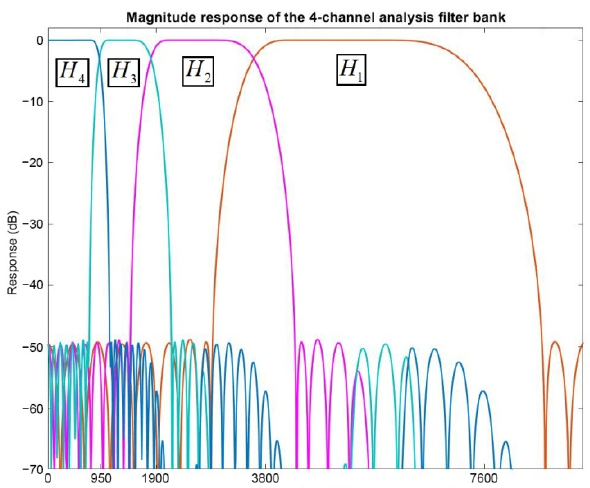
Figure 5. The frequency response for analysis filter bank related to CuNMA.